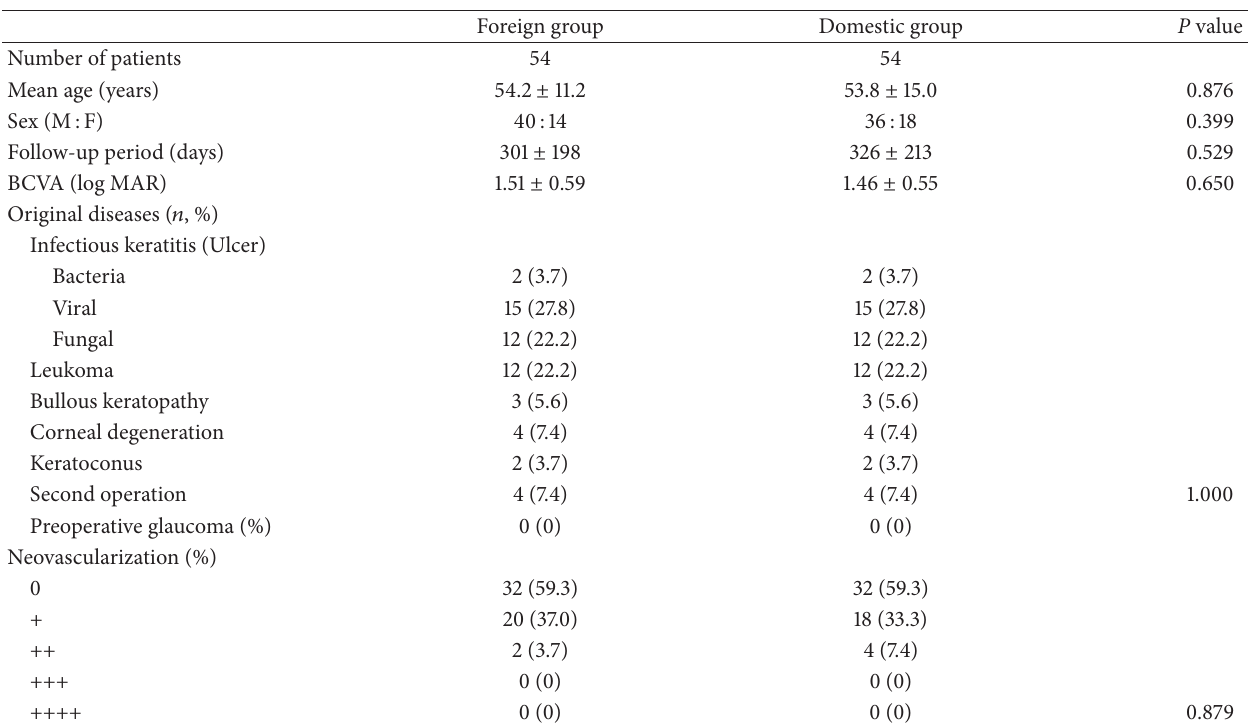
Table 1: Patients’